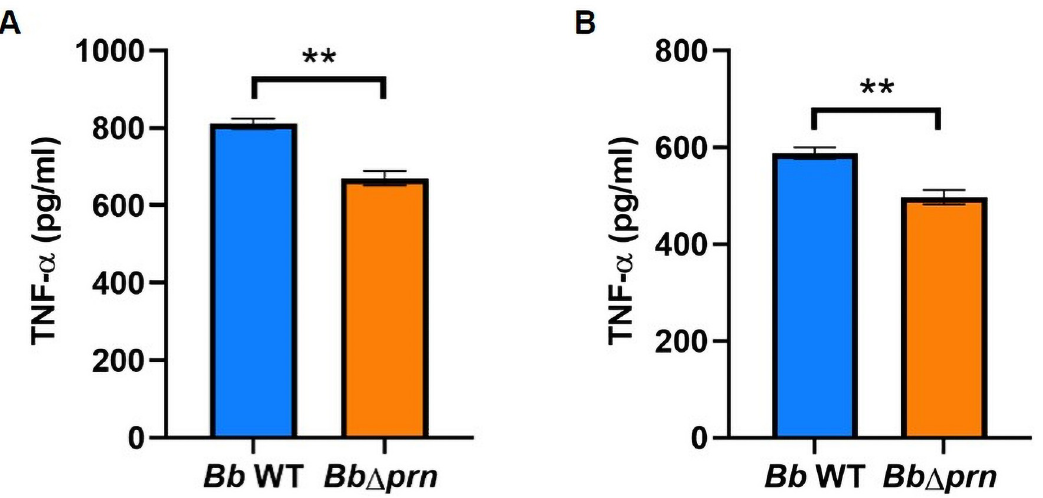
Fig 5. PRN induces the secretion of TNF- α from RAW 264.7 macrophages. TNF- α secretion from macrophages when exposed with Bb WT (blue) or Bb Δ prn (orange) for 1 hour with MOI at 10 (A) or MOI at 100 (B). Error bar shows the standard error of mean. Statistical significance was calculated using unpaired T test. � p < 0.05, �� p < 0.01, ��� p <